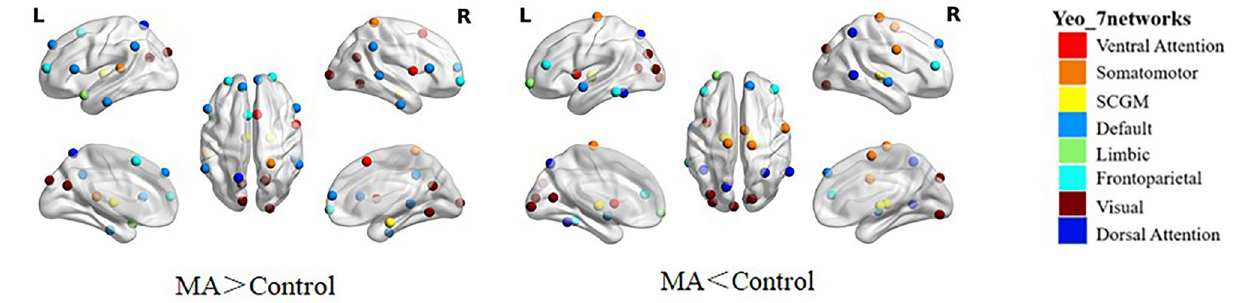
Figure 3. Brain regions with significant differences in hubness scores between methamphetamine- dependent patients and healthy controls. Different colors of brain nodes represent different subnetworks of the Yeo_7networks. The statistical criterion for between-group differences was set at p < 0.005 after 5,000 permutation test. Detailed brain regions are described in Table S1, Supplementary Materials. MA: methamphetamine-dependent patients; control: healthy controls. SCGM = Subcortical gray